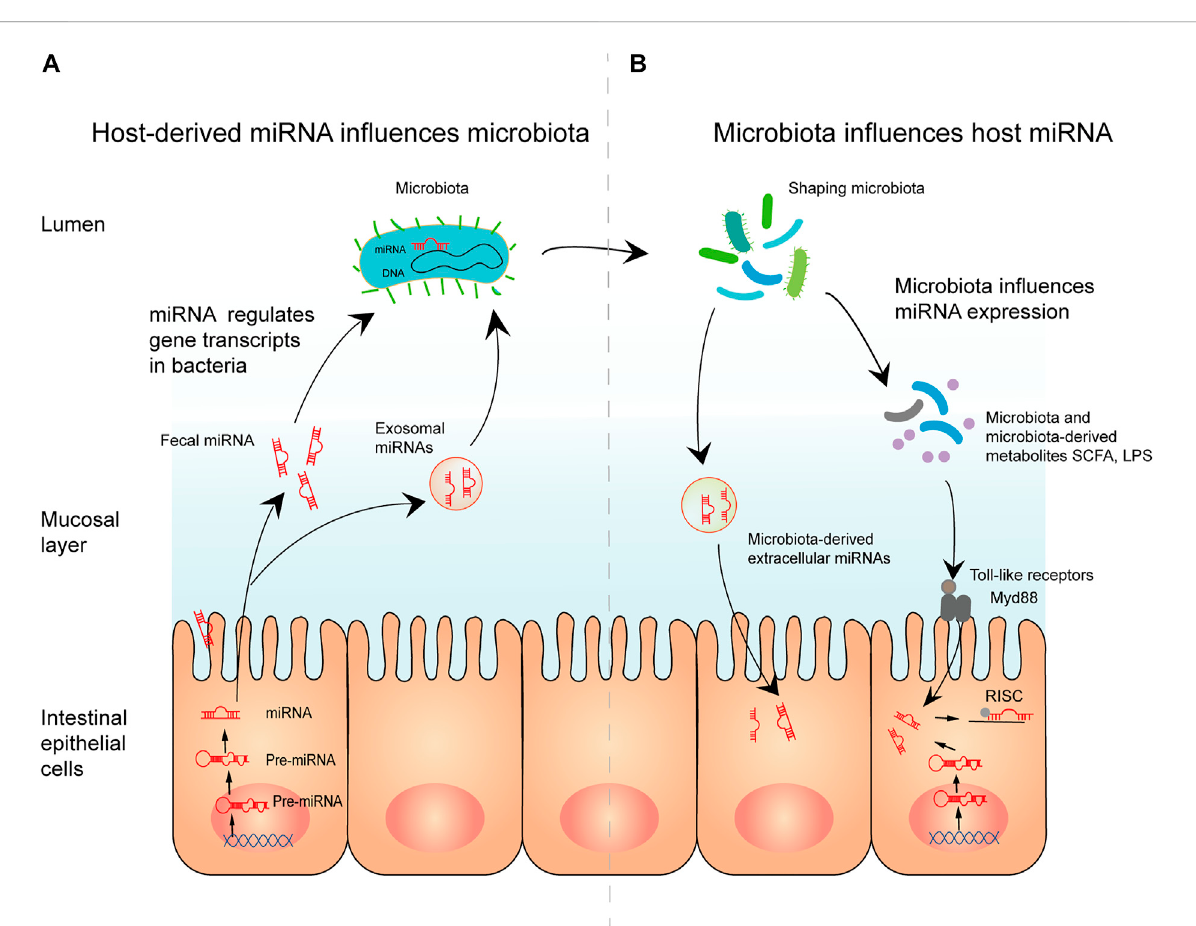
FIGURE 8 The mechanisms of interplay between miRNA and the microbiome. (A) Host-derived miRNA in fl uences microbiota. Mature miRNAs from intestinal epithelialcells can enter microbiota in theform offecalmiRNA orexosomalmiRNA.By regulating gene transcription in microbiota, miRNA affects microbial growth, thereby shaping the microbiota. (B) Microbiota in fl uences host miRNA. Microbiota and microbiota-derived metabolites regulate miRNA expression, possibly through toll-like receptor/Myd88-dependent pathways. Moreover, microbiota-derived extracellular vesicle can modulate gut barrier function and the immune response